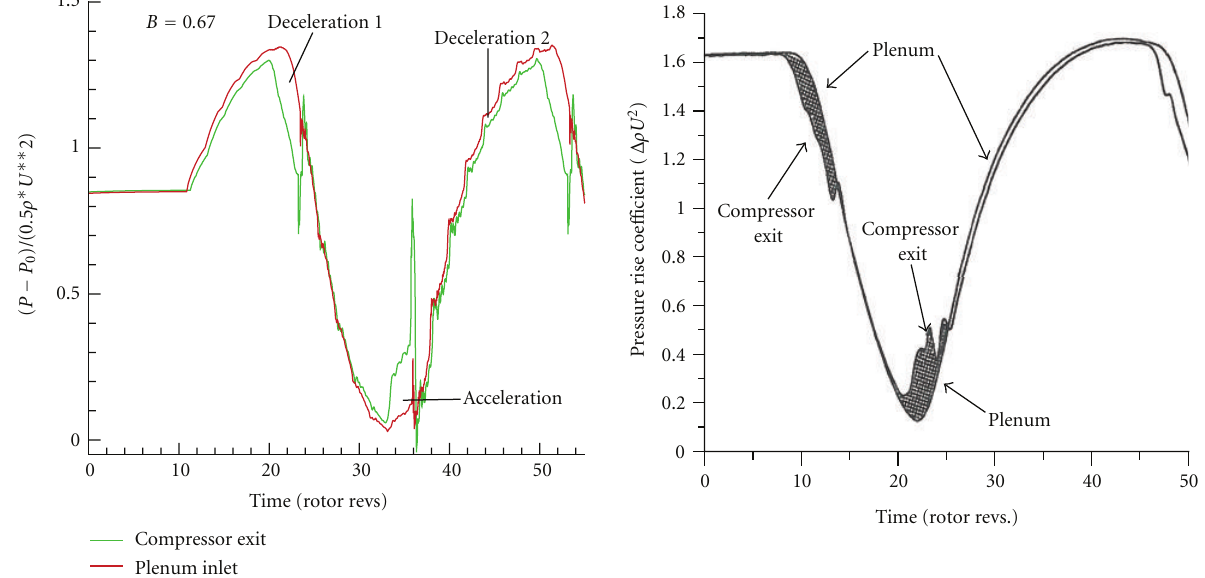
Figure 7: Numerical and experimental pressure di ff erences between compressor exit and plenum inlet [2].